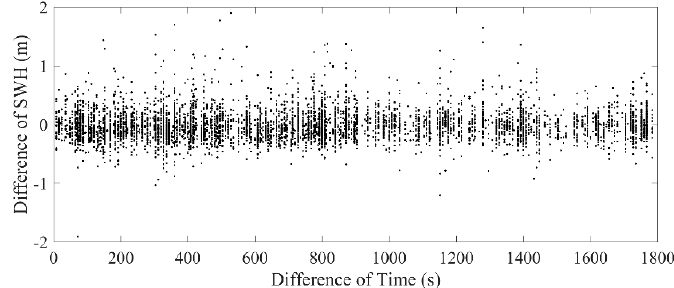
Figure 6. SWH difference of the collocated Sentinel-3A and buoy data at different observation time differences.